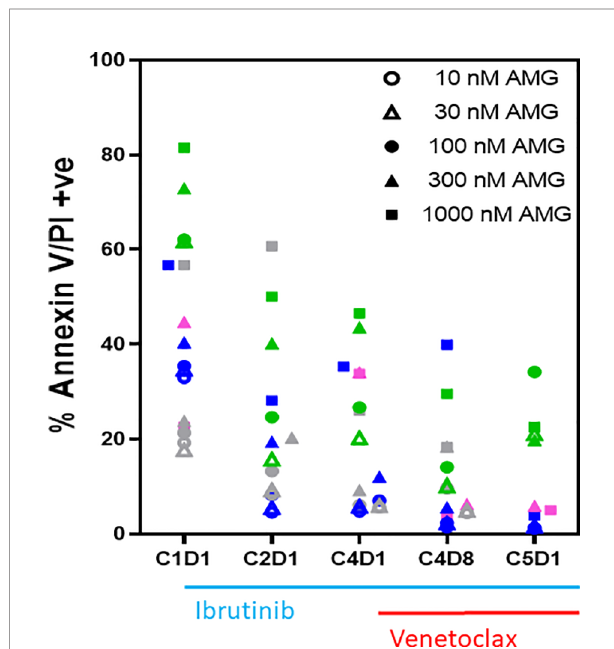
FIGURE 2 | Ex vivo sensitivity of PBMCs to AMG-176 during ibrutinib monotherapy and ibrutinib plus venetoclax therapy. PBMCs from patients during therapy were obtained from peripheral blood. PBMCs from 4 patients were incubated ex vivo with 10 – 1,000 nM of AMG-176 for 24 h. Cell death was determined using fl ow cytometry after Annexin V/propidium iodide (PI) staining. Each color represents a patient and symbol denotes concentration of drug. Colors for symbols for patient 518, 356, 214, and 221 are pink, gray, blue, and green, respectively. AMG, AMG-176, C, cycle and D,